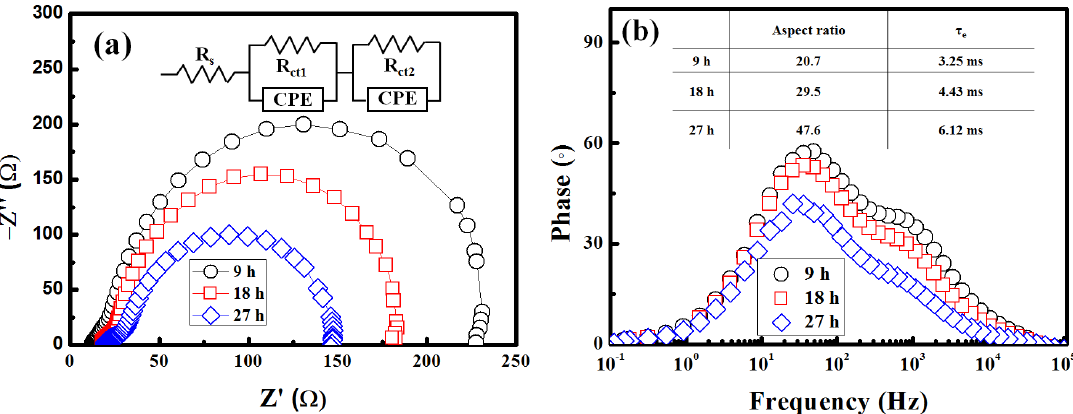
Figure 4. Electrochemical impedance spectra of DSSCs containing ZnO nanorods with various lengths. ( a ) Nyquist plots and ( b ) Bode phase plots. The equivalent circuit of this study is shown in the inset of ( a ).